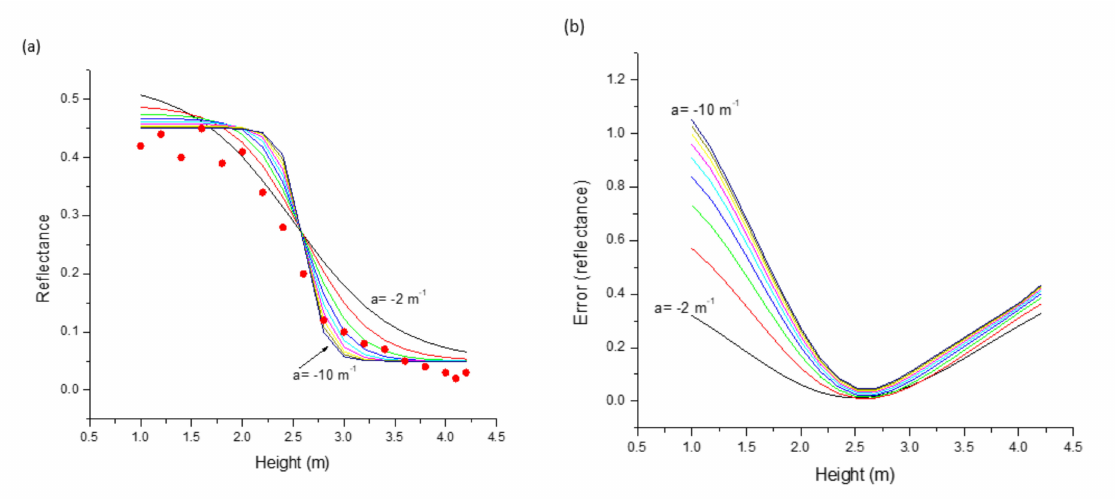
Figure 6. ( a ) NIR reflectance time series as a function of the tide height (red circles) and adjusted sigmoid function for a range of steepness parameters (from − 2 to − 10) and ( b ) cost function for a range of steepness